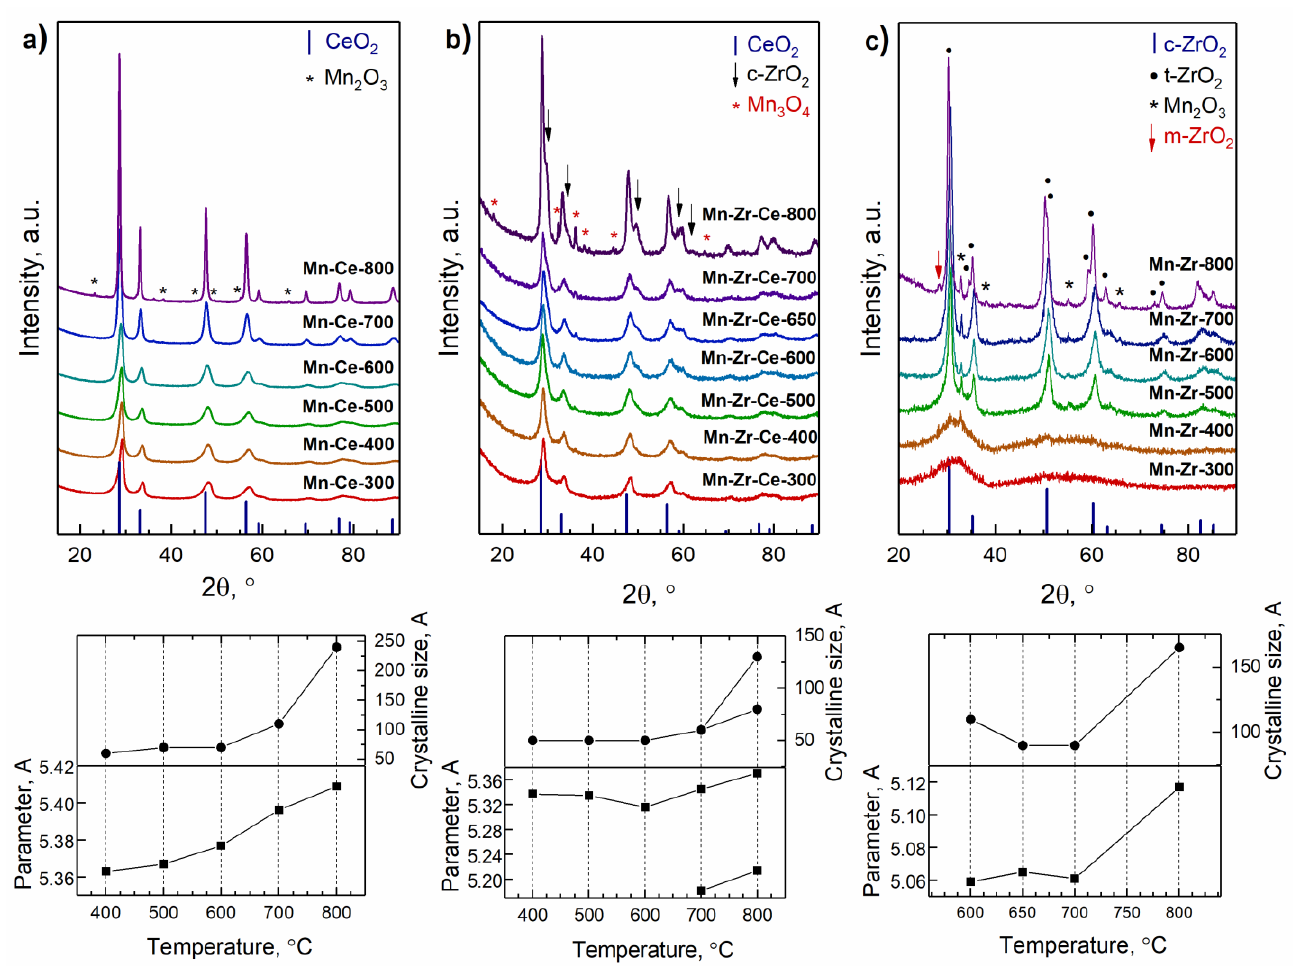
Figure 2. XRD data for ( a ) Mn-Ce, ( b ) Mn-Zr-Ce and ( c ) Mn-Zr catalysts activated at different tem- peratures.